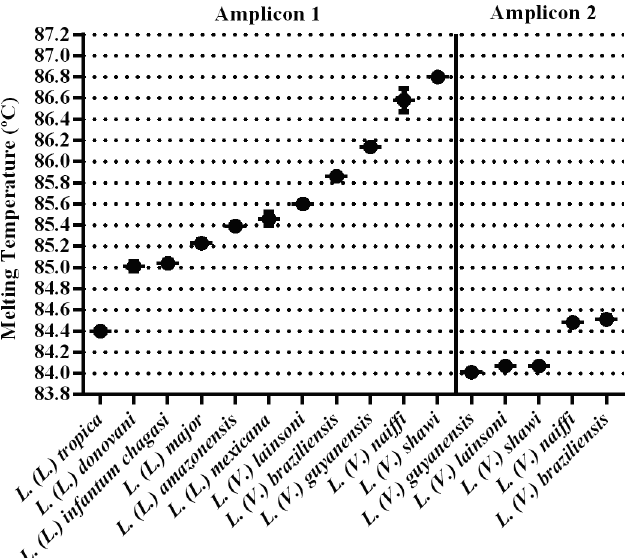
Fig 2. Tm values obtained with the HRM assay. Representative dispersion graph of individual Tm values for each studied Leishmania species using 50 ng of genomic DNA as a template for hsp70 amplicon 1 and amplicon 2. The plots show the average and standard deviation of the Tm values. Each species was tested in duplicate in three independent experiments.